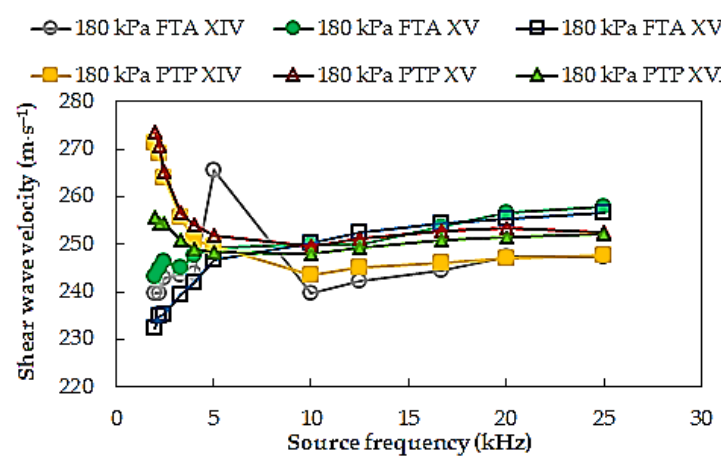
Figure 7. Shear wave velocities from multi-stage consolidation process.